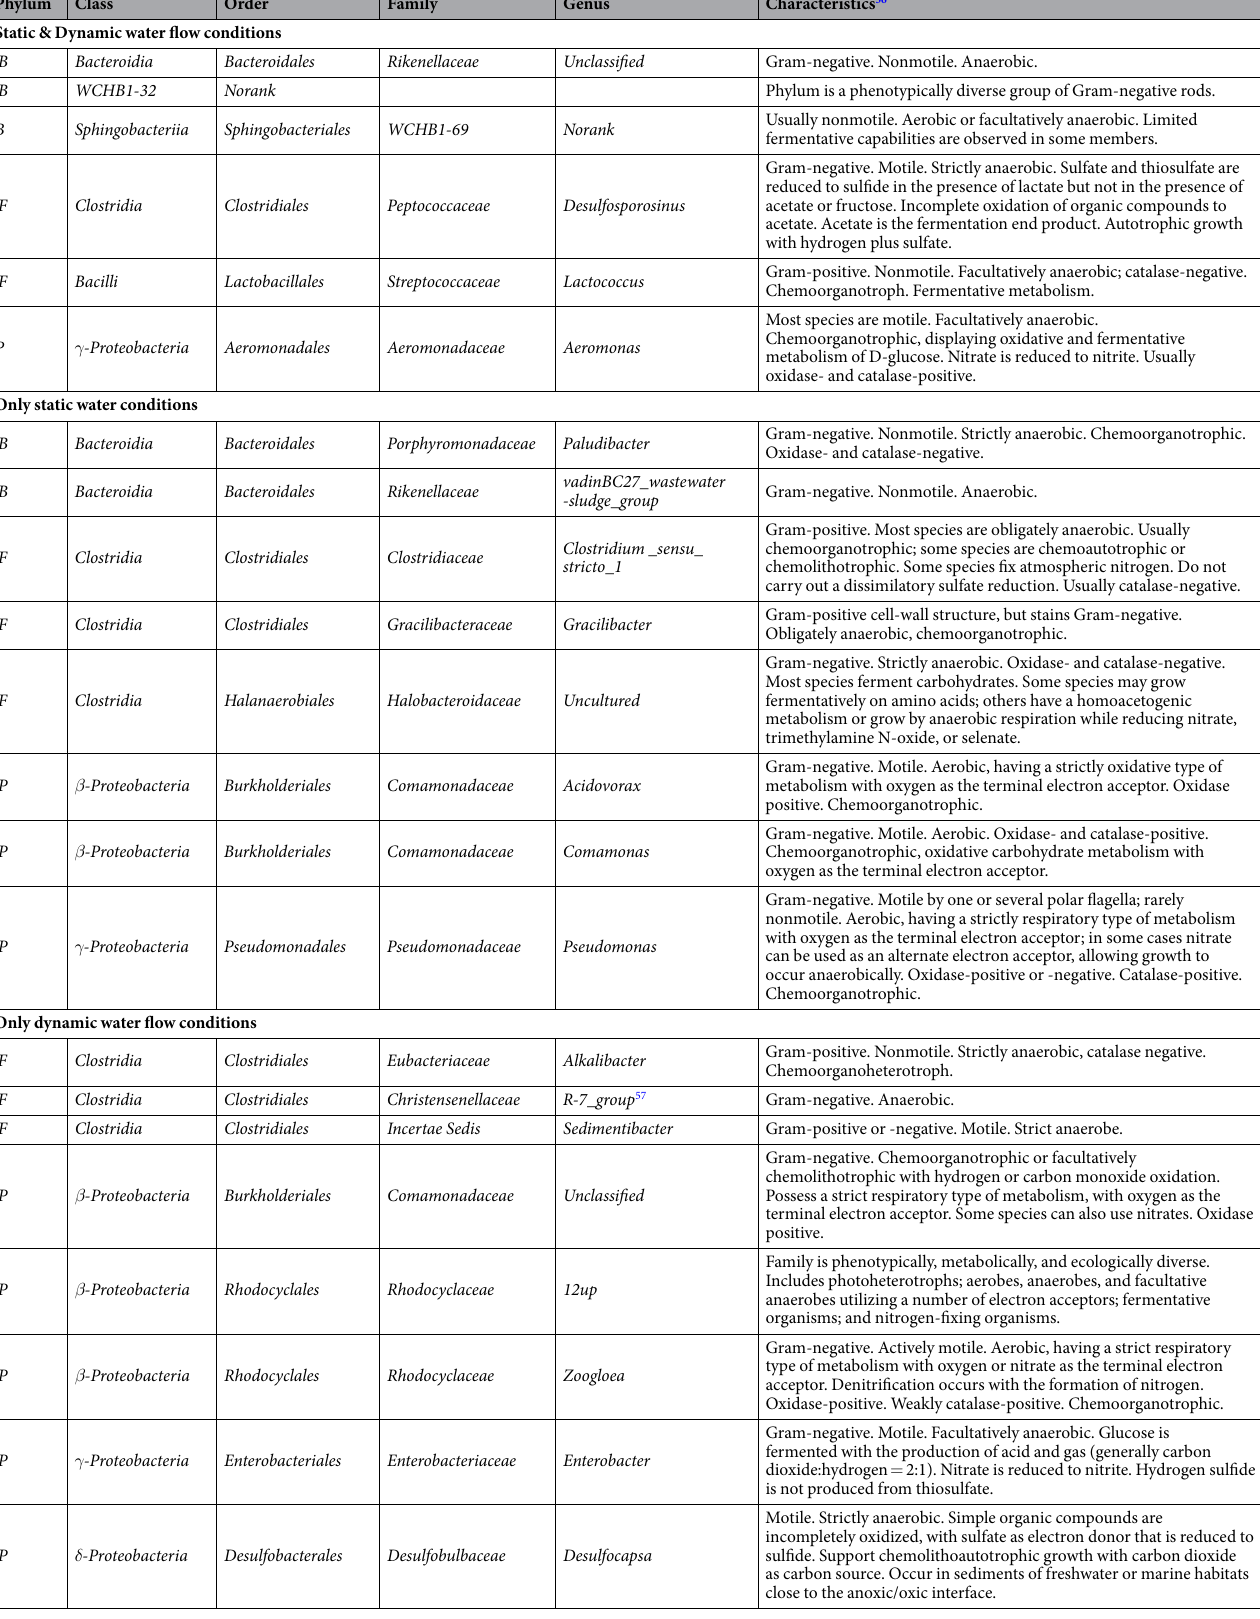
Table 4. Properties of the dominant bacteria at the genus level. B: Bacteroidetes; F: Firmicutes; P: